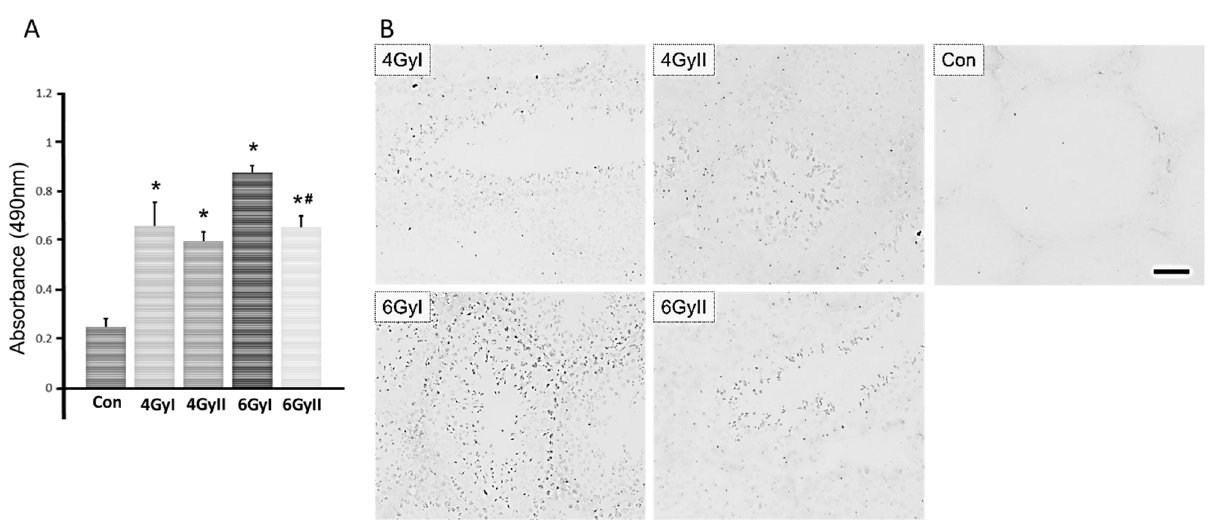
Figure 4. Detection of serum anti-germ cell antibody levels in each group. ( A ) ELISA measurements of autoantibodies in each group reactive with germ cells antigens. The results are expressed as the mean ± SD of five mice in each group. * P < 0.05 vs. control group; # P < 0.05 vs. group I. ( B ) Normal frozen sections of seminiferous tubules were reacted with diluted sera obtained from each group mice followed by incubation with horseradish peroxidase (HRP)-conjugated anti-mouse IgM. Scale bar, 50 mm.